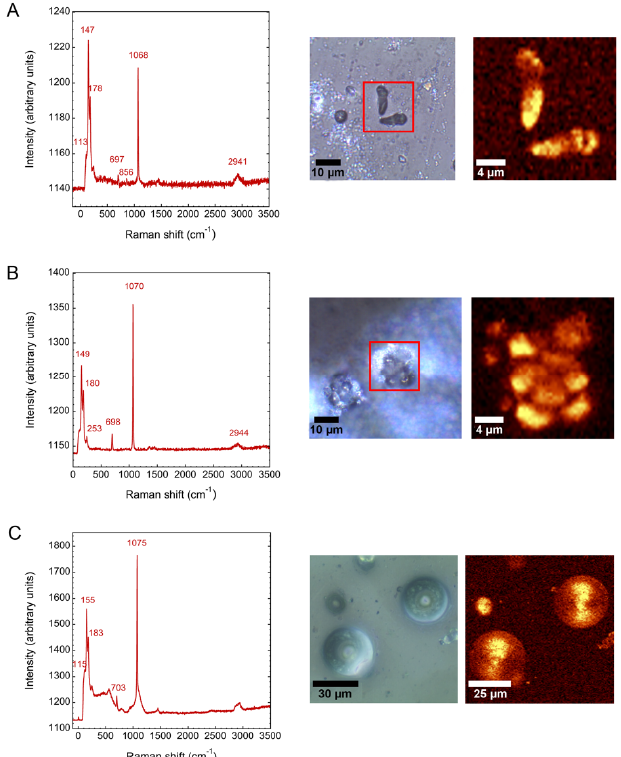
Figure 8. Raman spectroscopic analysis of strontianite silica carbonate biomorphs obtained in different conditions. ( A ) Control in the absence of enzyme. ( B ) Suberitis domuncula silicatein- α . ( C ) Tethya aurantia silicatein- α . Left panels correspond to the Raman spectra. Right panels correspond to the optical image and mapping at the most intense Raman signal.